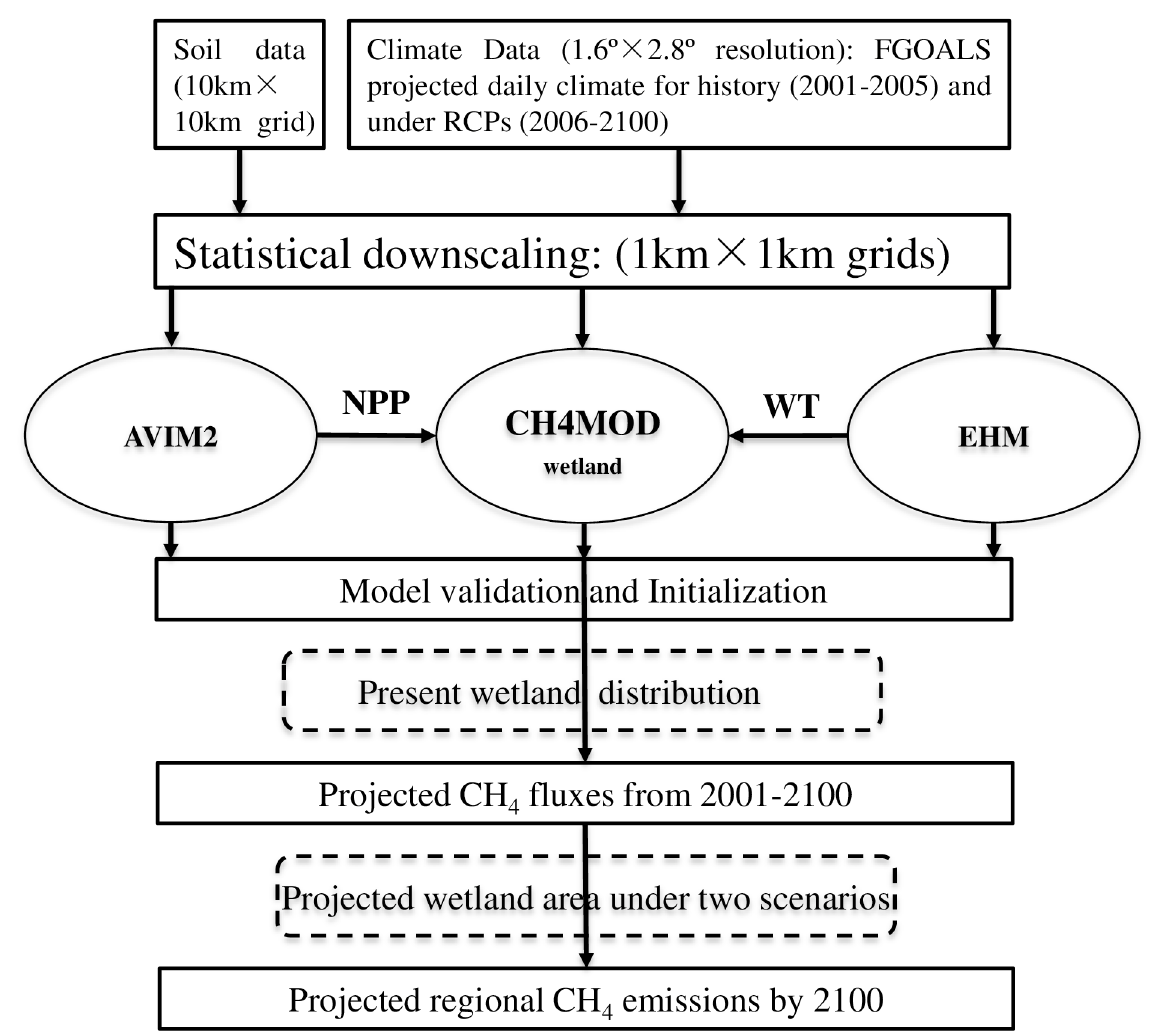
Fig 2. Model framework for simulating CH 4 emissions from the Sanjiang Plain from 2001 – 2100 under RCPs. CH4MOD wetland is a biogeophysical model to simulate CH 4 fluxes from natural wetlands. AVIM2 (Atmospheric-Vegetation Interaction Model, version 2) is a process-based terrestrial ecosystem model that simulates seasonal and interannual variations in biophysical and biogeochemical processes at the land surface. EHM is an empirical hyrological model to simulate daily water table